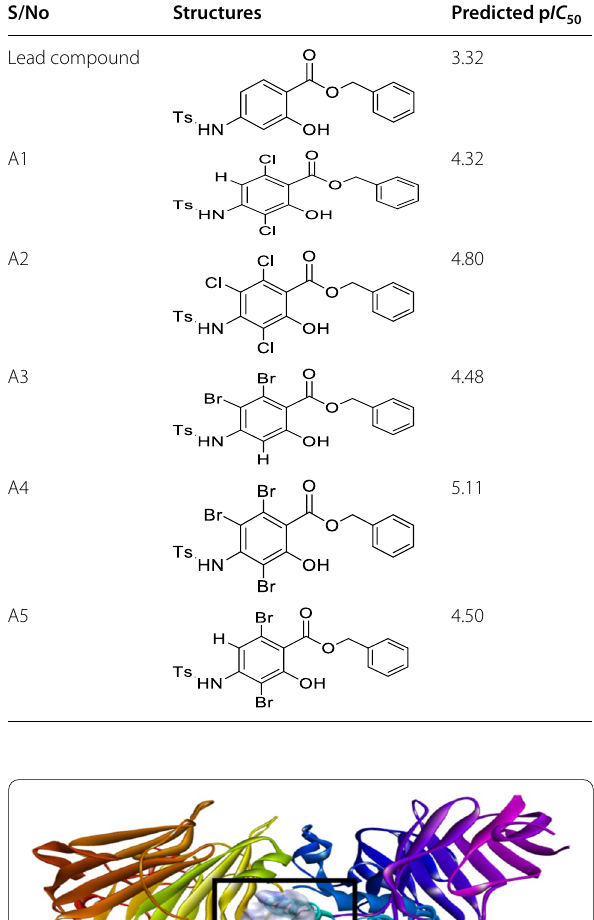
Table 5 Structures, predicted pIC the designed analogues